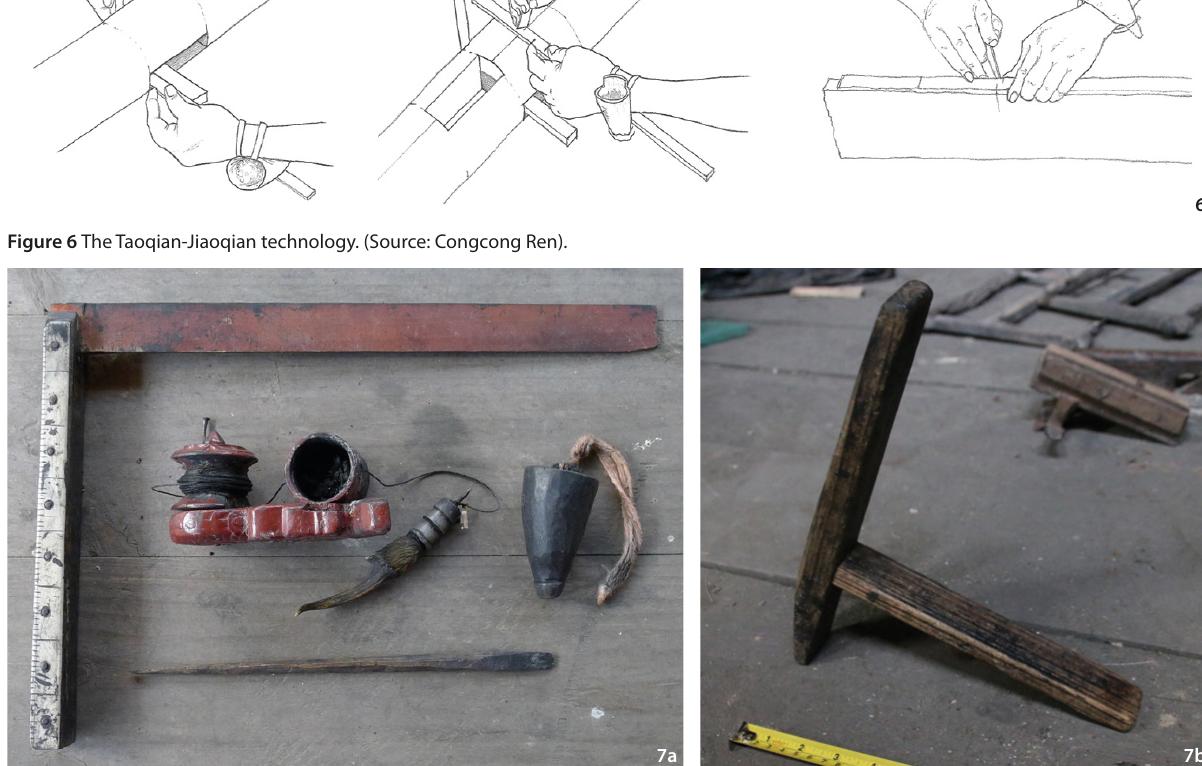
Figure 7a Tools used for the mark-ink work (Source: Congcong Ren). Figure 7b Douchi (Source: Congcong Ren).